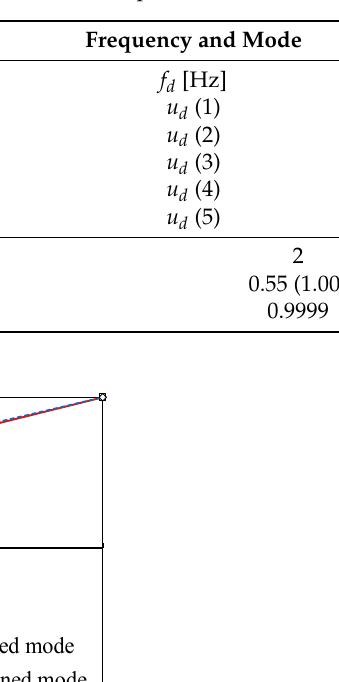
Figure 13. Original FRFs and FRFs after the addition of supporting stiffness. Table 8. Comparison of natural frequencies and mode shapes.